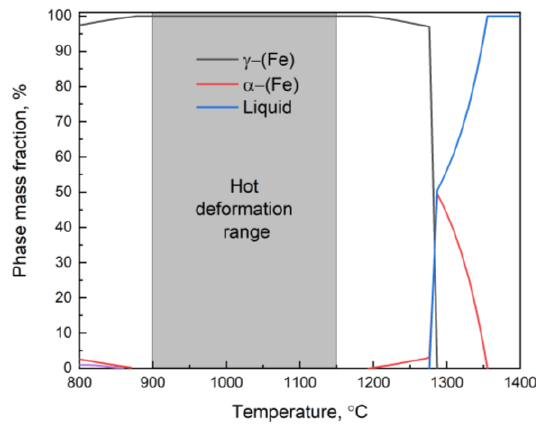
Figure 3. Grain microstructure and phase composition of the Fe – 28Mn – 8Al – 1C steel before defor- mation: SEM ( a ) and XRD pattern ( b ).